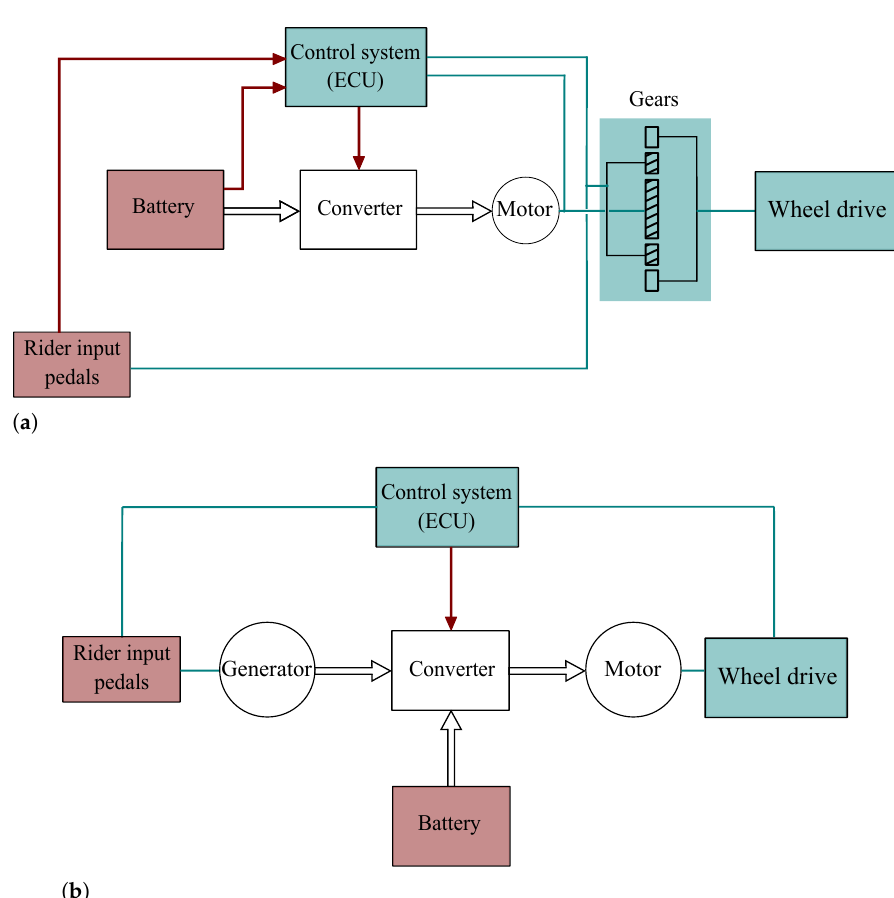
Figure 3. Comparison of parallel and serial e-bike configurations. ( a ) Parallel configuration. ( b ) Serial configuration.